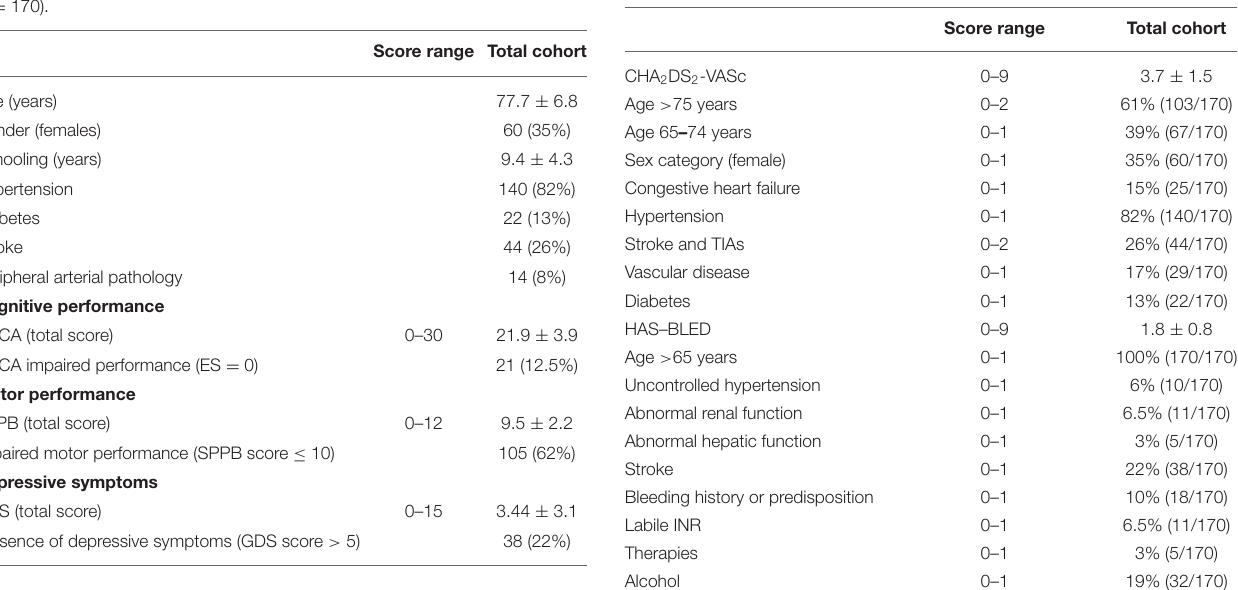
TABLE 2 | Frequency distributions of CHA 2 DS 2 -VASc and HAS–BLED items in the baseline Strat-AF study cohort ( n =